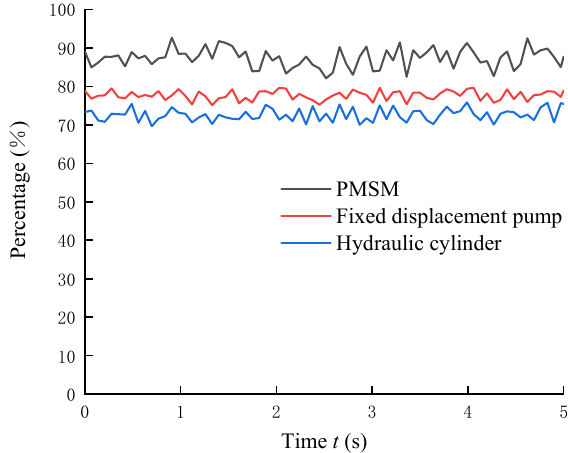
Figure 10. Energy output ratio of key components.